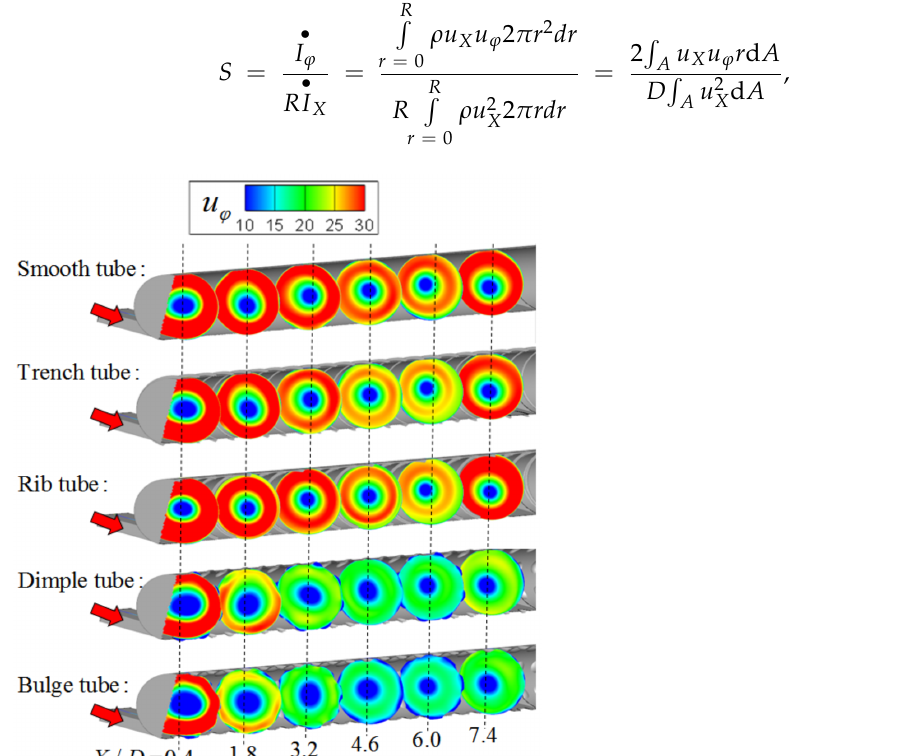
Figure 10. Circumferential velocity distributions on several cross sections in the swirl tube with various surface structures at Re D = 50,000 with three jets.